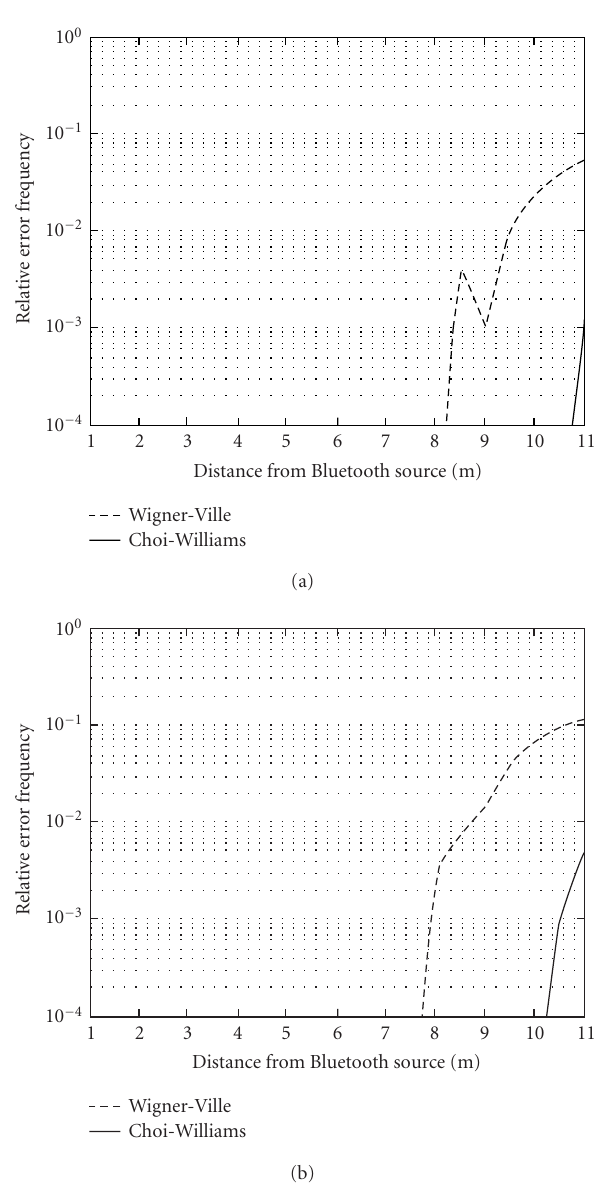
Figure 7: Relative error frequency of Bluetooth by using (a) the SVM and (b) the